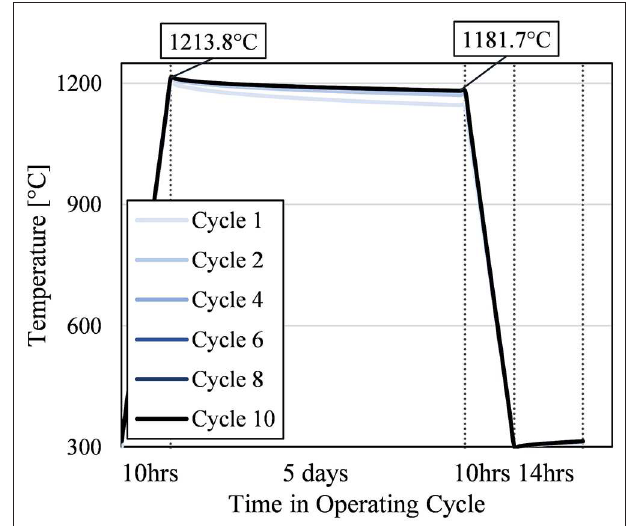
FIGURE 8 | Bulk average particle temperature over selected operational cycles; not all cycles are presented for conciseness. Vertical dotted lines mark changes in operating step; x-axis is not to